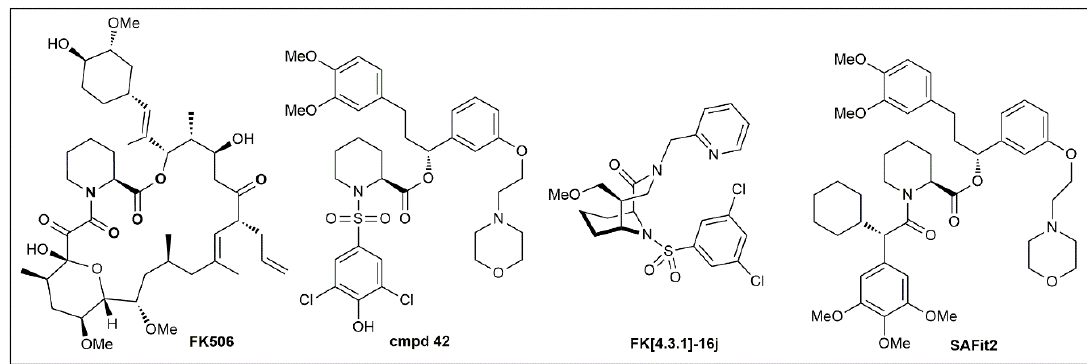
Figure 5. Chemical structures of important FKBP51 ligands.